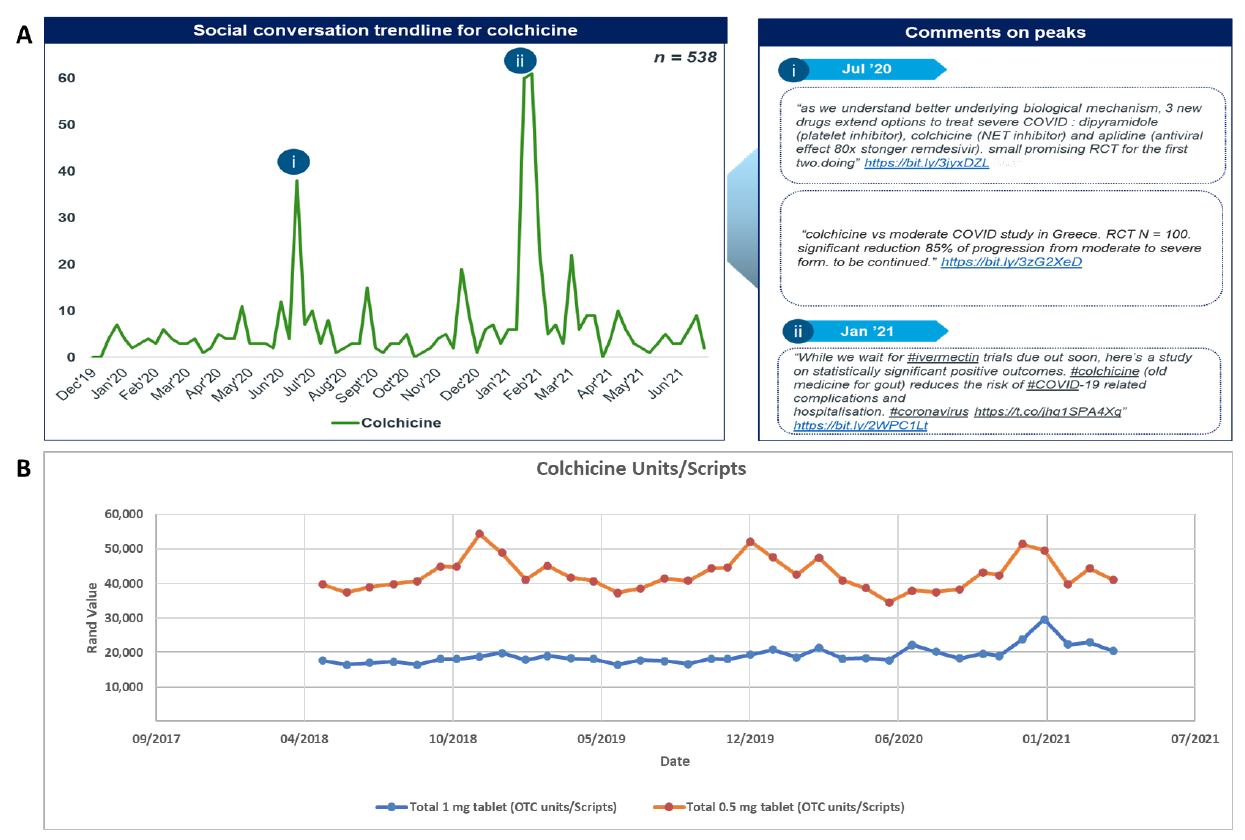
Figure 4. ( A ) Social conversation trendline for colchicine and ( B ) utilisation trendline as units/scripts for colchicine.